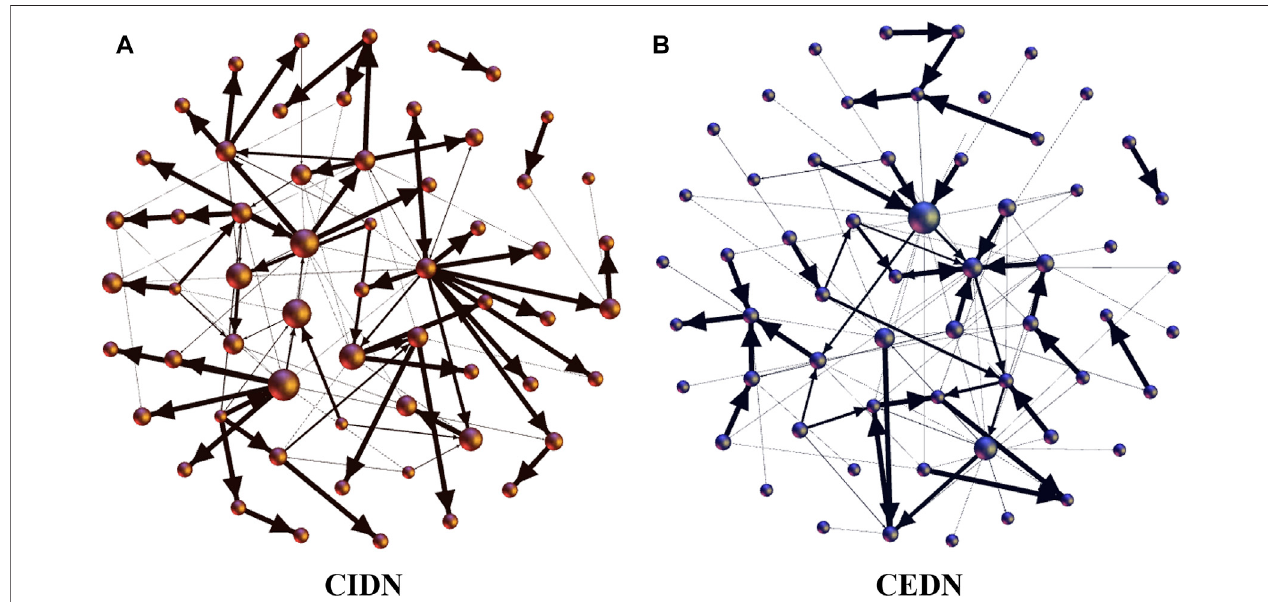
FIGURE 1 | The cobalt trade dependence network in 2019 ( (A) and (B) represent the cobalt import dependence network and the cobalt export dependence network respectively).